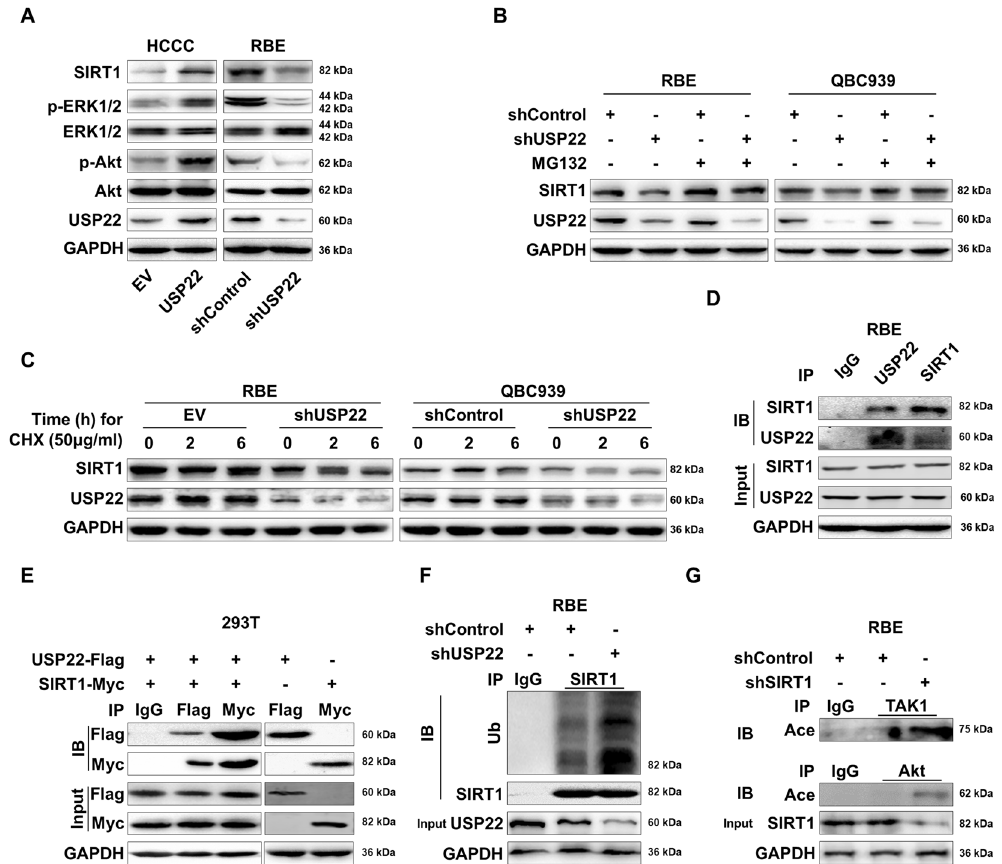
GAPDH. B RBEshUSP22/RBE-shControl or QBC939-shUSP22/QBC939-shControl were cultured ± MG132 (10 μ M) for 6 h. Cells were lysed and prepared for immunoblotting analysis with antibodies to SIRT1, USP22 and GAPDH. C RBE-shUSP22/RBE-shControl or QBC939-shUSP22/QBC939- shControl were cultured ± cycloheximide (CHX) 50 μ g/ml and harvested at the time points of 2 and 6 h, and cells were lysed for immunoblotting analysis with antibodies to SIRT1 and USP22. D Cell lysates from RBE-shControl and RBE-shUSP22 were prepared for reciprocal pull-down and immunoblotting analysis with antibodies to IgG, USP22 and SIRT1. E 293 T cells were grown and cotransfected with Flag-tagged USP22 and Myc-SIRT1, and the cell lysates were prepared for immunoprecipitation and immunoblotting analysis with antibodies to IgG, Flag and Myc. F , G RBE-shControl and RBE-shUSP22 cells were cultured and cell lysates were prepared for immunoprecipitation with antibodies to IgG, SIRT1, TAK1 or Akt. They were analysed by immunoblotting with antibodies to ubiquitin, SIRT1, USP22, pan-acetylation, TAK1, Akt, and GAPDH. All data shown are representative of three independent